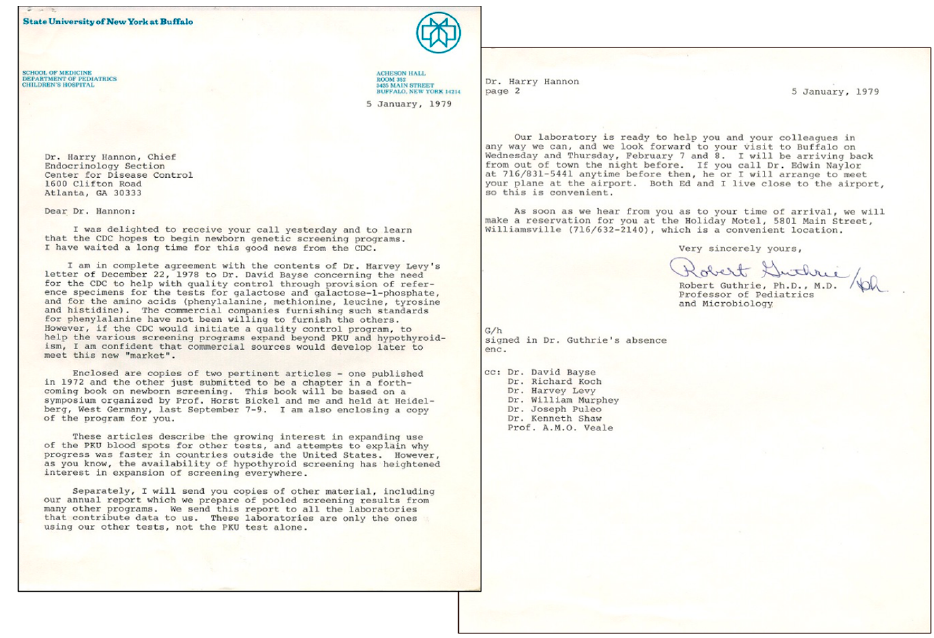
Figure 2. Personal letter to Dr. Hannon from Dr. Robert Guthrie in 1979 regarding CDC activities.